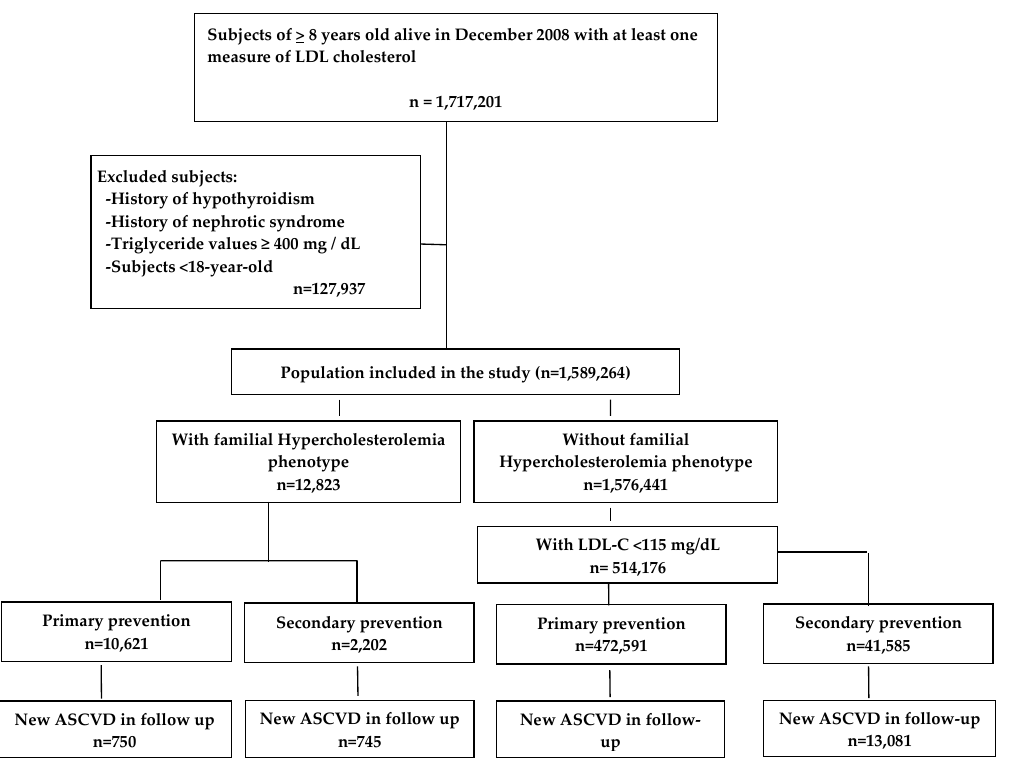
Figure 1. Study flowchart. ASCVD indicates Atherosclerotic Cardiovascular Disease. LDL: Low-density lipoprotein; LDL-C: Low-density lipoprotein cholesterol; ASCVD: Atherosclerotic cardiovascular diseases.